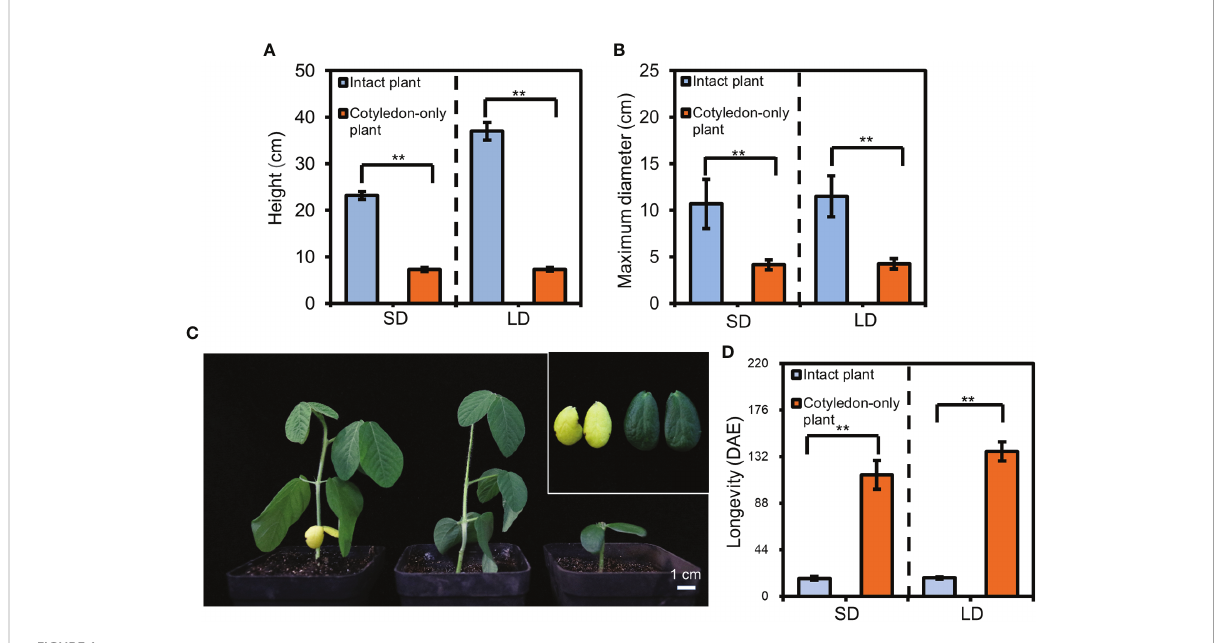
FIGURE 1 The height, maximum diameter, and cotyledon longevity of cotyledon-only plants (COPs) and intact plants. (A) The plant height for ZGDD COPs and intact plants. (B) The maximum diameter for ZGDD COPs and intact plants. Five plants were calculated in each experiment in (A) and (B) . (C) Comparison of cotyledons from the intact plant and COPs of ZGDD. The left plant is the intact plant with yellow cotyledons, the middle is the intact plant without cotyledons, and the right is the COP. A close-up view of the cotyledons from the intact plant and COP in C is shown in the top right. The photos in (C) were taken from 16-d-old plants. (D) The longevity of cotyledons from the COPs and intact plants of ZGDD grown under SD and LD conditions. Fifteen plants were included in (D) . DAE indicates d after emergence. Error bars indicate the standard deviation. Double asterisks indicate an extremely signi fi cant difference ( t -test, p value <